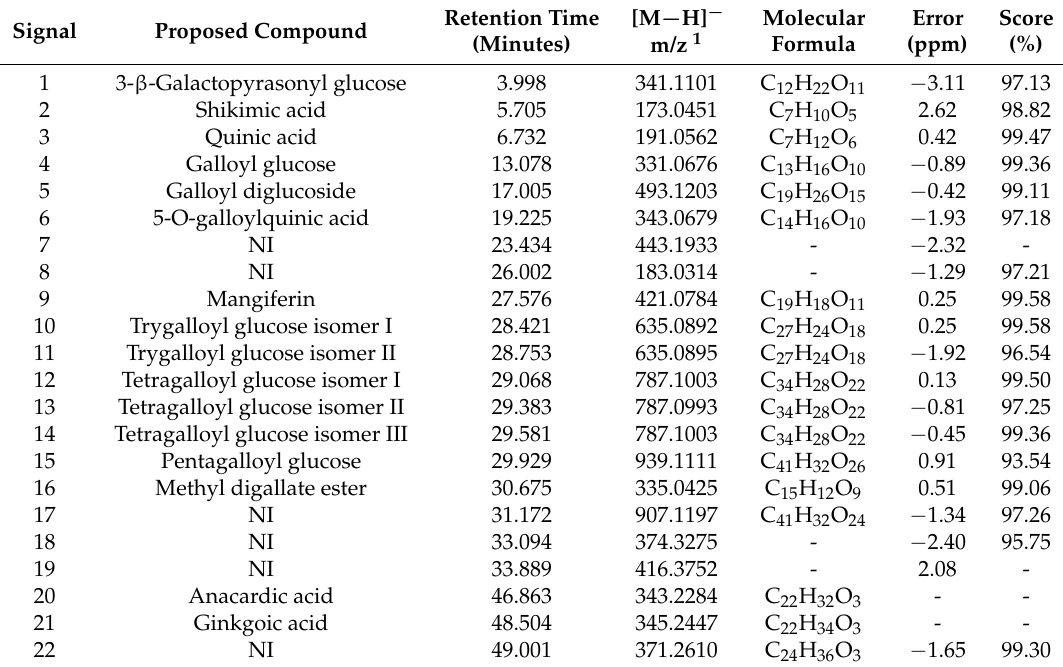
Figure 3. Antiproliferative activity of the extract obtained from the ‘sugar mango’ seed kernel. Cell lines: A-549 (lung adenocarcinoma), HT-29 (colorectal adenocarcinoma), MDA-MB-231 (breast adenocarcinoma), and PC-3 (prostate cancer). Table 4. Phenolic compounds tentatively identified by HPLC–ESI-MS(Q-TOF) in the extract obtained from ‘sugar mango’ seed